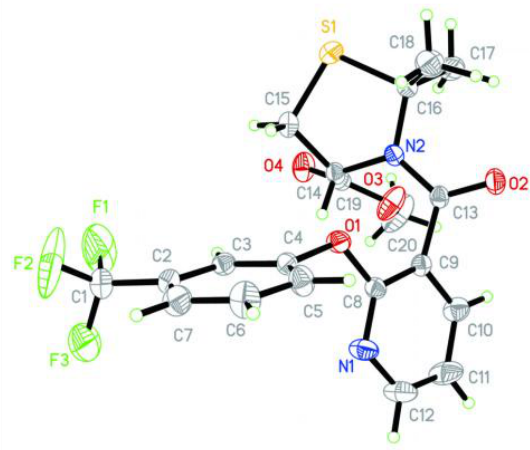
Figure 2. Crystal structure of compound 4a.